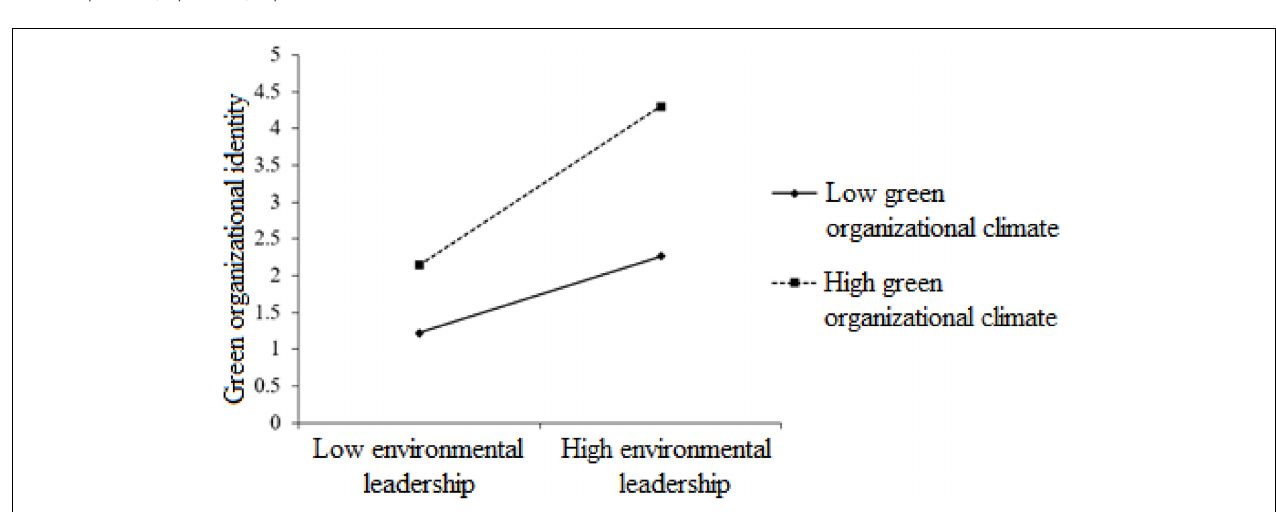
FIGURE 2 | The moderating effect of green organizational climate on the relationship between environmental leadership and green organizational